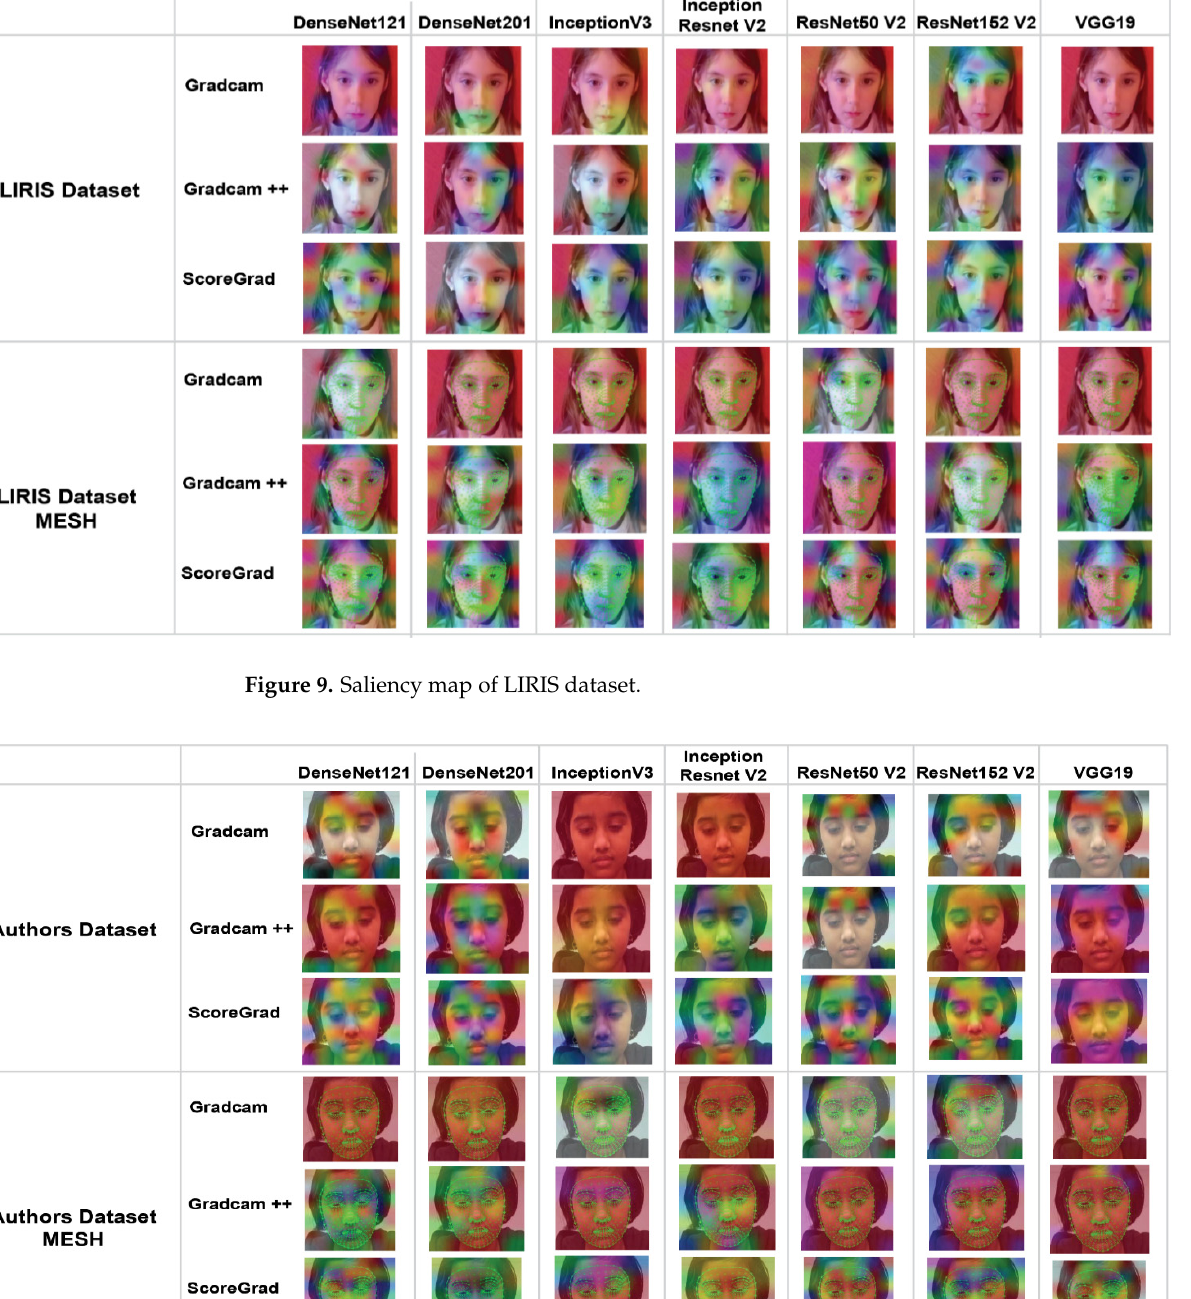
Figure 10. Saliency map of authors' dataset.